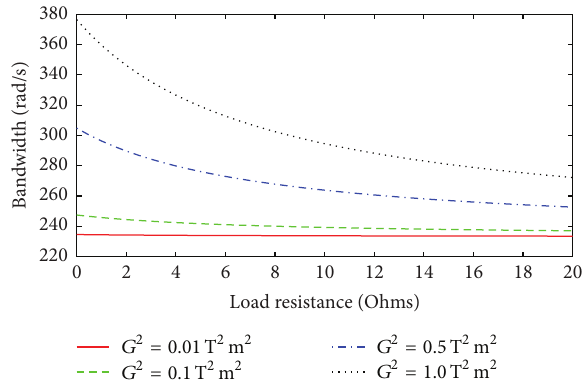
Figure 5: Linear EMEH bandwidth as a function of the load resistance for different values of 𝐺 2 and 𝑄 𝑚 = 5.7 .